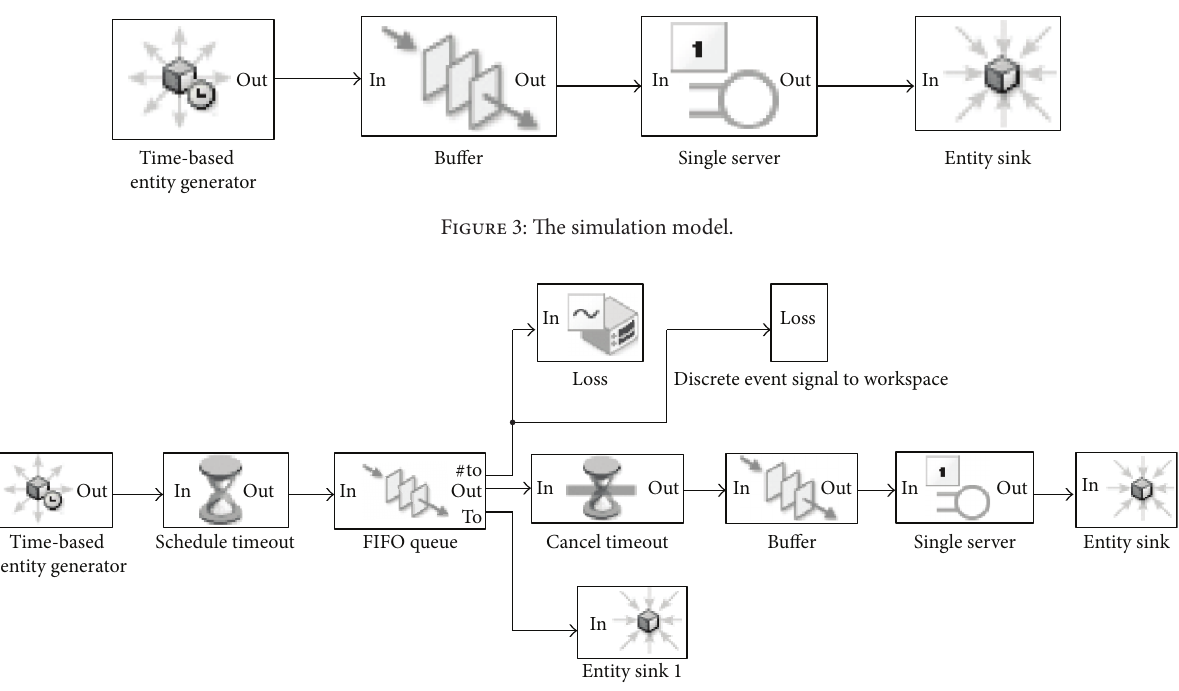
Figure 4: The revised simulation model.